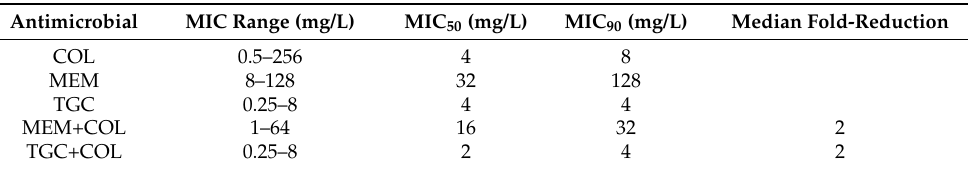
Table 1. MIC, MIC 50 , and MIC 90 for COL, MEM, and TGC as collected from single MIC testing by broth microdilution for 50